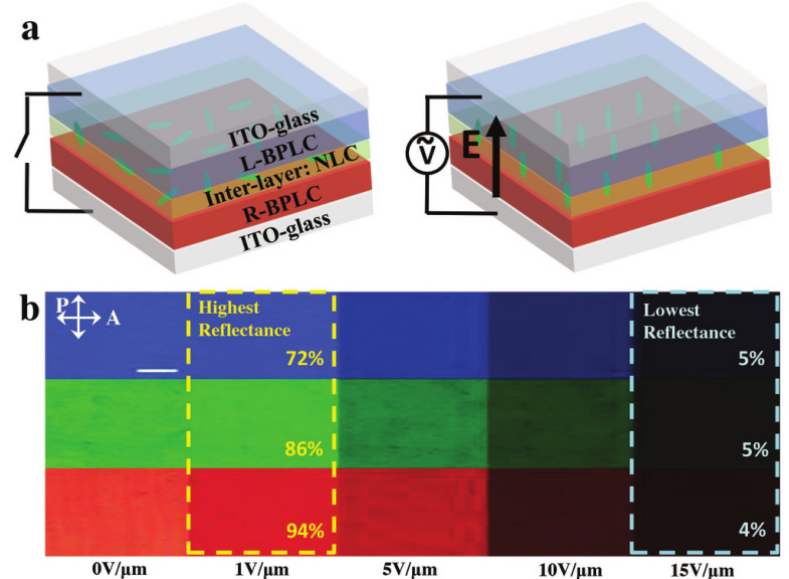
Figure 6. ( a ) Configurations of the BPLC film with and without an electric field. ( b ) Polarized optical microscopy images of the multi-layer BPLC film in blue, green and red color regions under increasing electric field [72] . Electrically Switchable, Hyper-Reflective Blue Phase Liquid Crystals Films from Luo, Advanced Optical Materials; published by John Wiley and Sons.